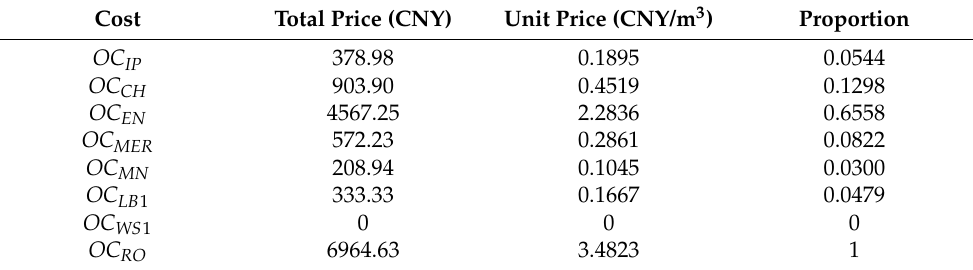
Table 22. SWRO system cost ratio table.